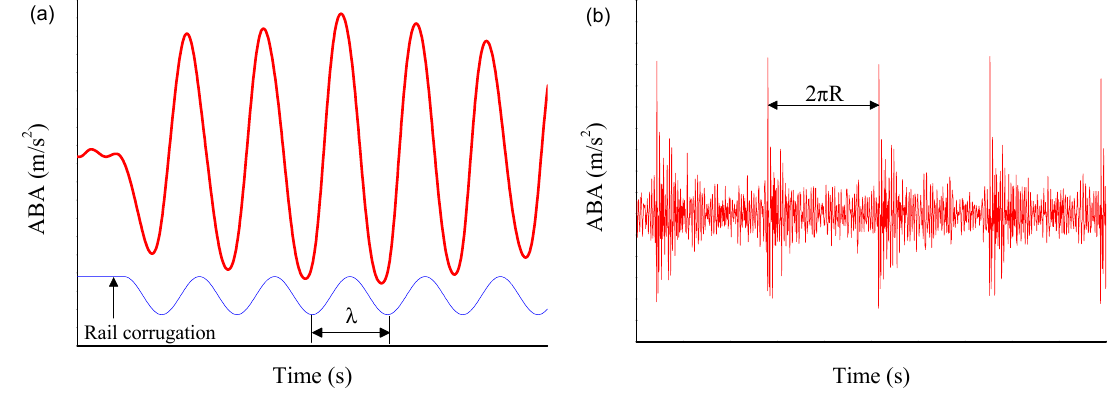
Figure 17. Schematic diagrams of axle box acceleration induced by ( a ) rail corrugation and ( b ) wheel flat.